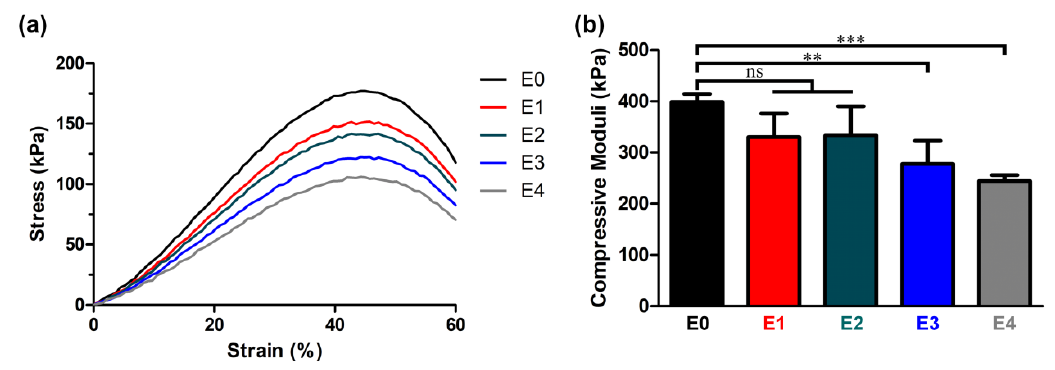
Figure 5. ( a ) Stress-strain curves of ESM / GG hydrogels. ( b ) Compressive moduli of ESM / GG hydrogels containing di ff erent amounts of ESMs. Error bars mean the standard deviation (n = 4). One-way ANOVA with Dunnett’s multiple comparison test was carried out to compare the compressive moduli of ESM / GG hydrogels containing di ff erent concentrations of ESMs. In Graph Pad Prism 6 software, a significant di ff erence is indicated as follows: NS (not significant) p > 0.05, ** p < 0.01, and *** p < 0.001.